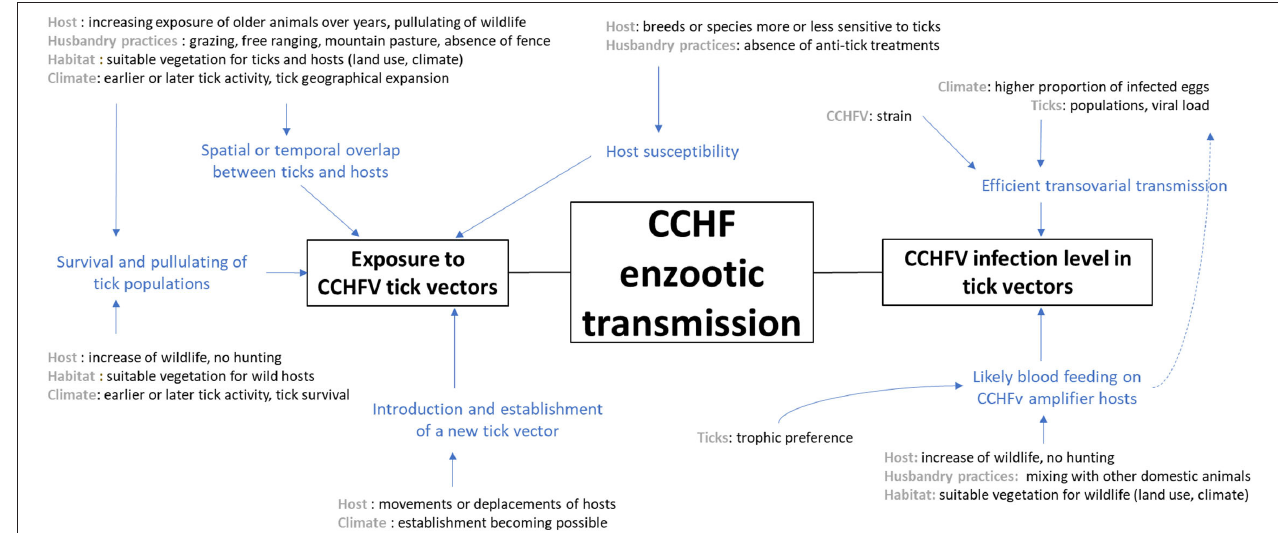
FIGURE 3 | Scheme representing factors that may impact either the exposure of animals to tick vectors or the CCHFV infection level of tick vectors, which could finally influence the CCHFV enzootic transmission in